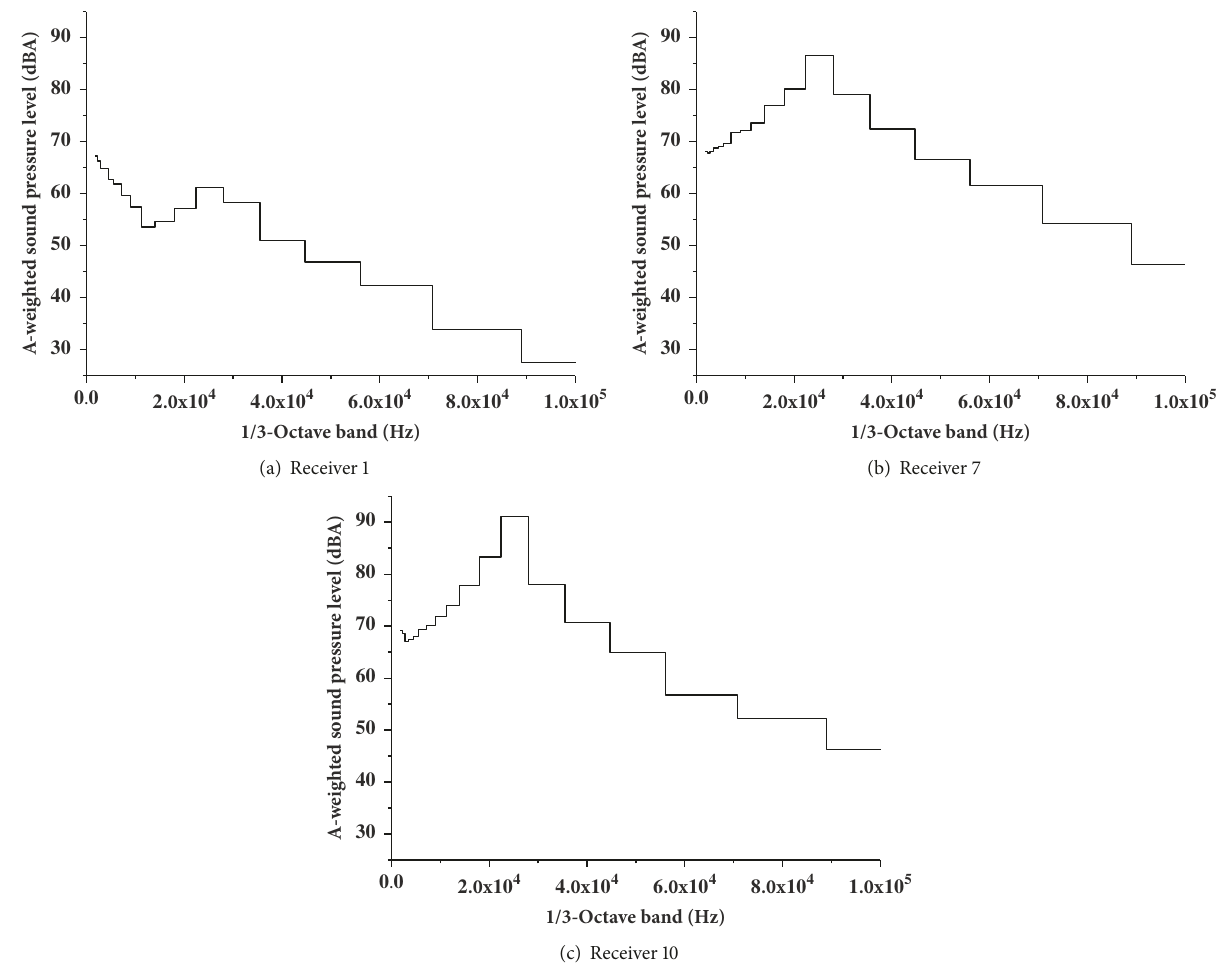
Figure 11: Sound pressure level distribution of typical receivers under scheme